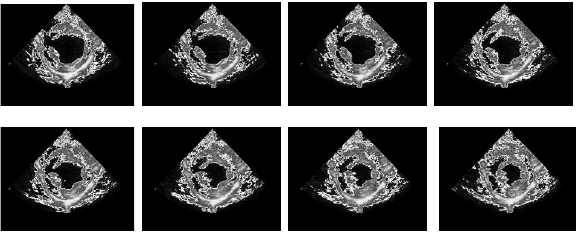
Figure 12. Pulse-Coupled Neural Network Echocardiogram Cineloop